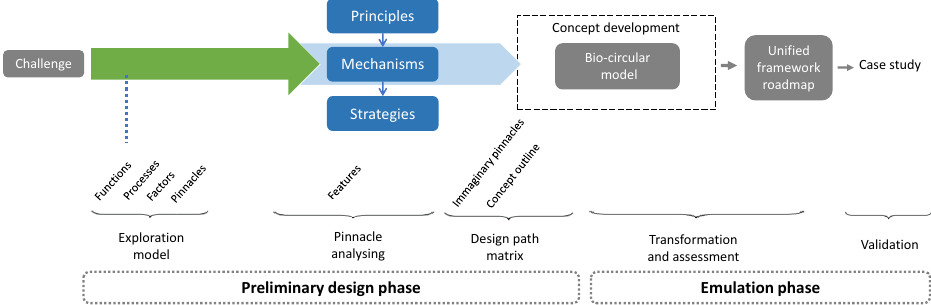
Figure 3. Schematic of the methodology